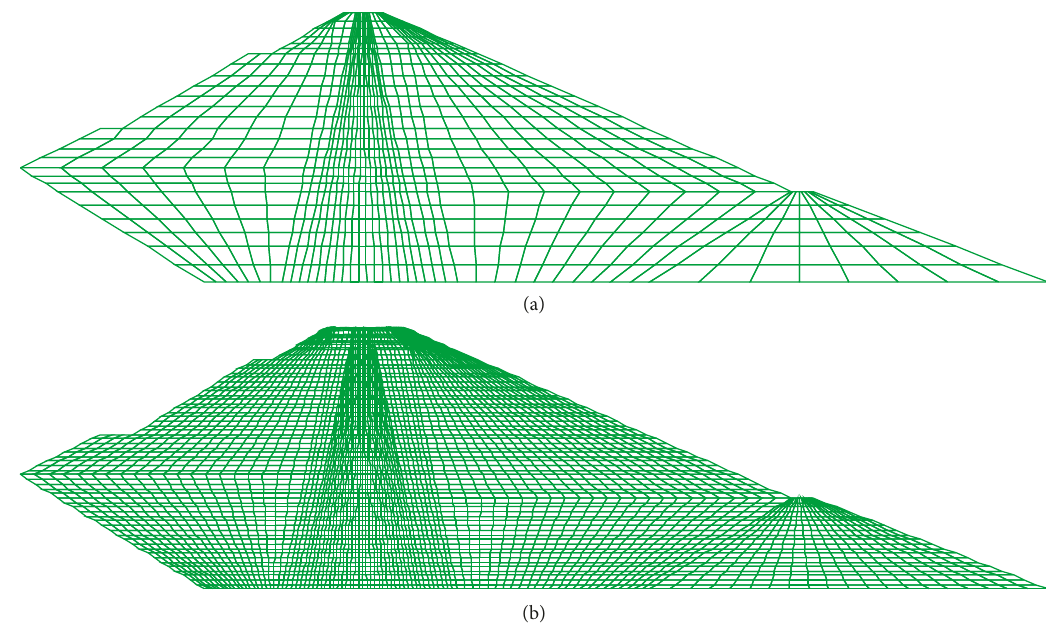
Figure 1: First and second samples’ meshing. (a) Coarse mesh size (1300 elements). (b) Fine mesh size (7200